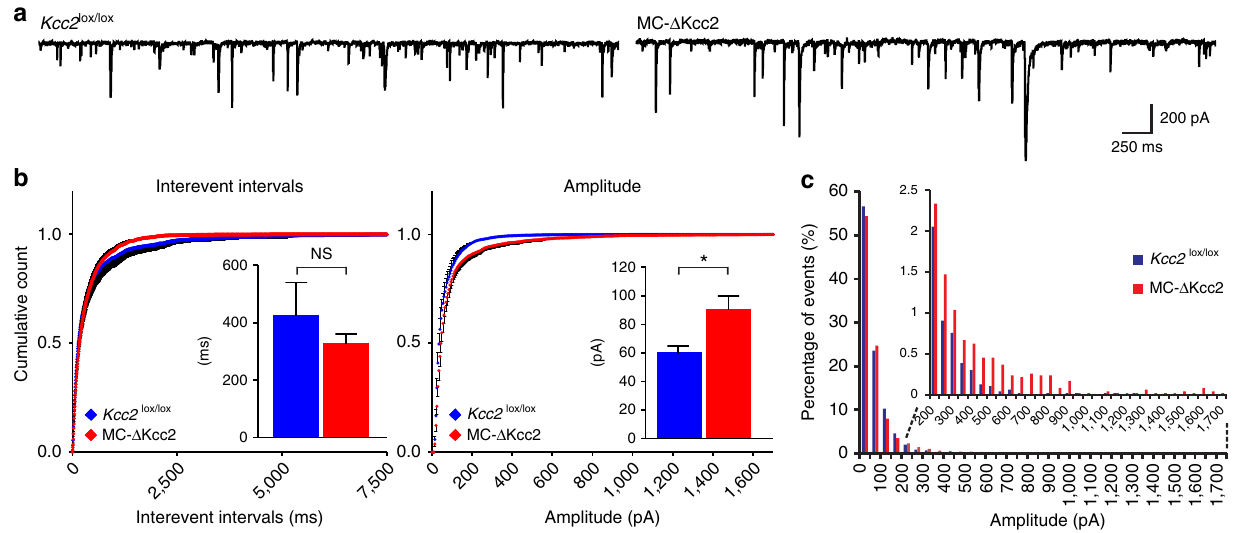
Figure 4 | Effect of Kcc2 deletion on miniature inhibitory postsynaptic currents in MCs. ( a ) Sample traces of mIPSCs measured in MCs of MC- D Kcc2 mice and Kcc2 lox/lox control mice, recorded in the voltage clamp configuration at (cid:2) 70mV. ( b ) Mean cumulative probability and mean mIPSCs interevent intervals and amplitudes of MC- D Kcc2 mice ( n ¼ 20 cells) compared to Kcc2 lox/lox ( n ¼ 18 cells). Mean þ s.e.m. is shown. Mean amplitudes are statistically different between the genotypes (* P p 0.05, Mann–Whitney test). Bin size for cumulative comparison was 5pA and 5ms, respectively. Cumulative probabilities are plotted with only positive or negative black error bars that represent s.e.m. ( c ) Frequency histogram showing percentage distribution of mIPSC amplitudes with a bin size of 50pA. Inset displays histogram for amplitudes 4 200pA. 4622 events were analysed per genotype. Distributions differ with an asymptotic significance (two-sided) o 0.0005 (Kolmogorov–Smirnov